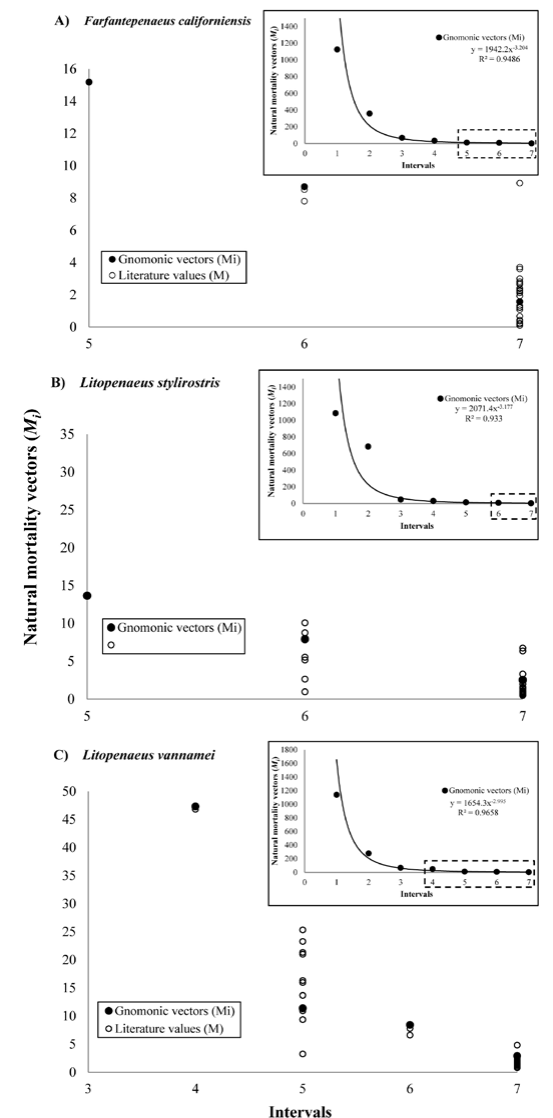
Fig. 1. – Natural mortality vectors estimated for brown ( F. cali- forniensis ) (A), blue ( L. stylirostris ) (B), and white ( L. vannamei ) shrimps (C) with the gnomonic model are shown in solid black cir- cles. Independent estimations from the literature are shown in solid white